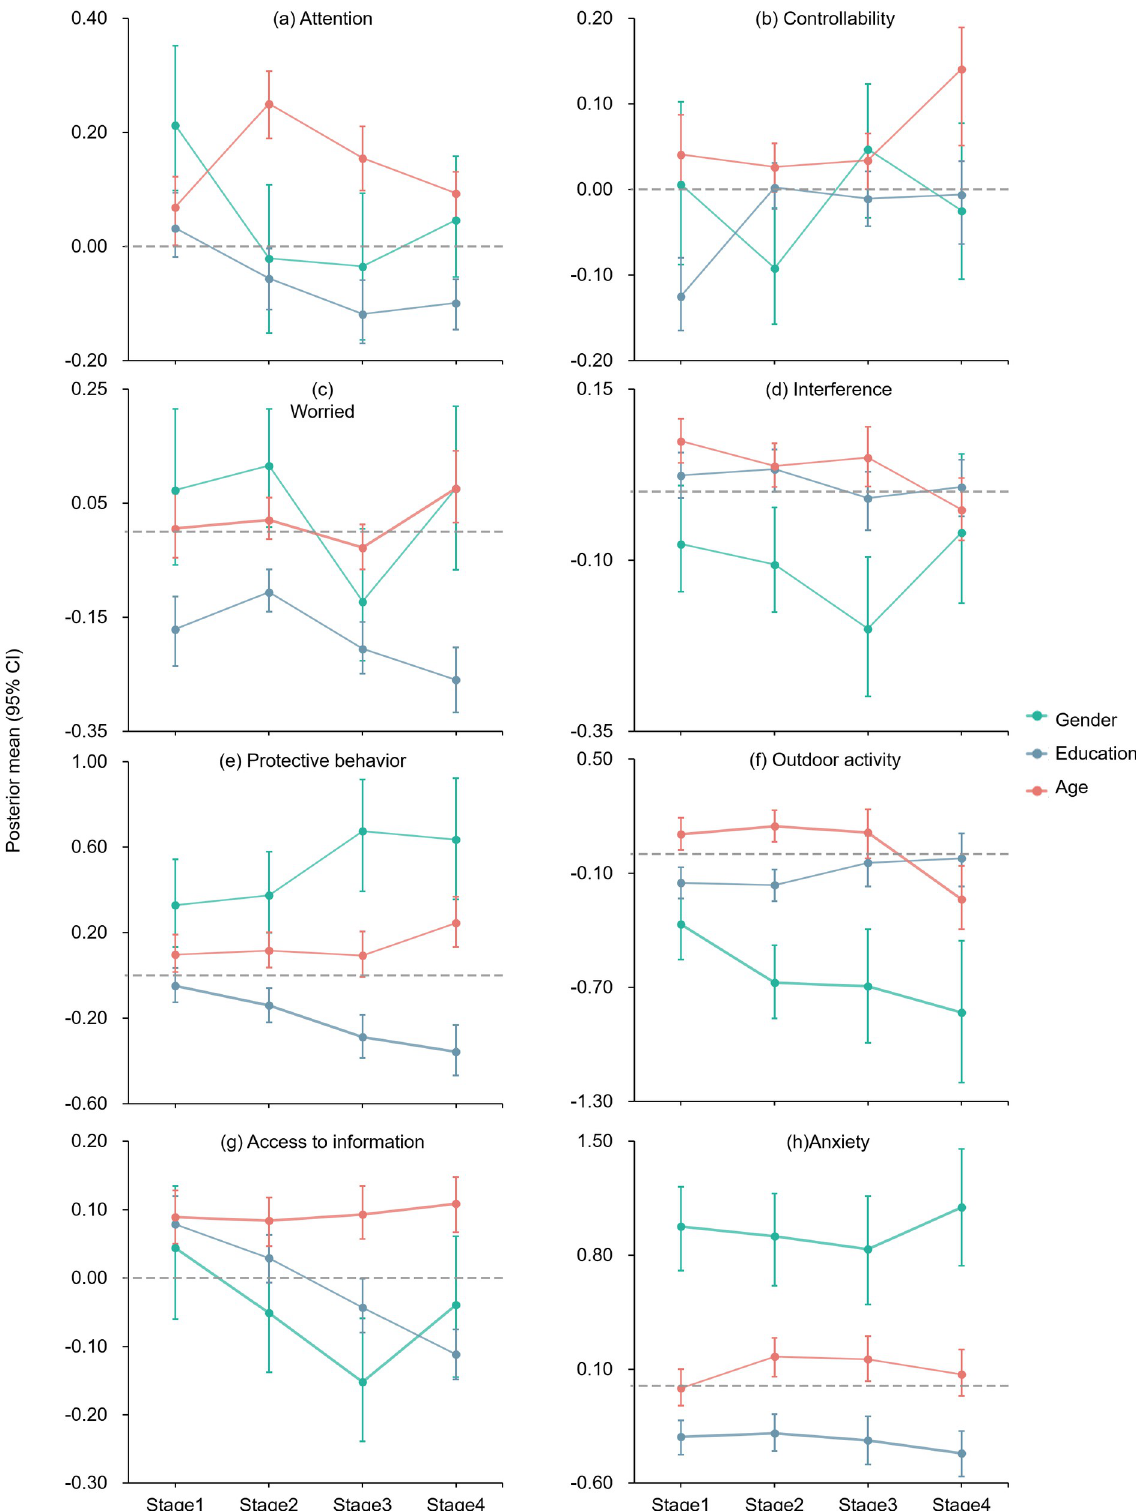
Fig 3. The impacts of individual characteristics on respondents’ risk perceptions (a, b, c, d), coping behaviors (e, f, g) and anxiety level (h) in different stages. The dot represents the Post. means of female vs. male, the senior vs. the junior, and the more educated vs. the less educated and